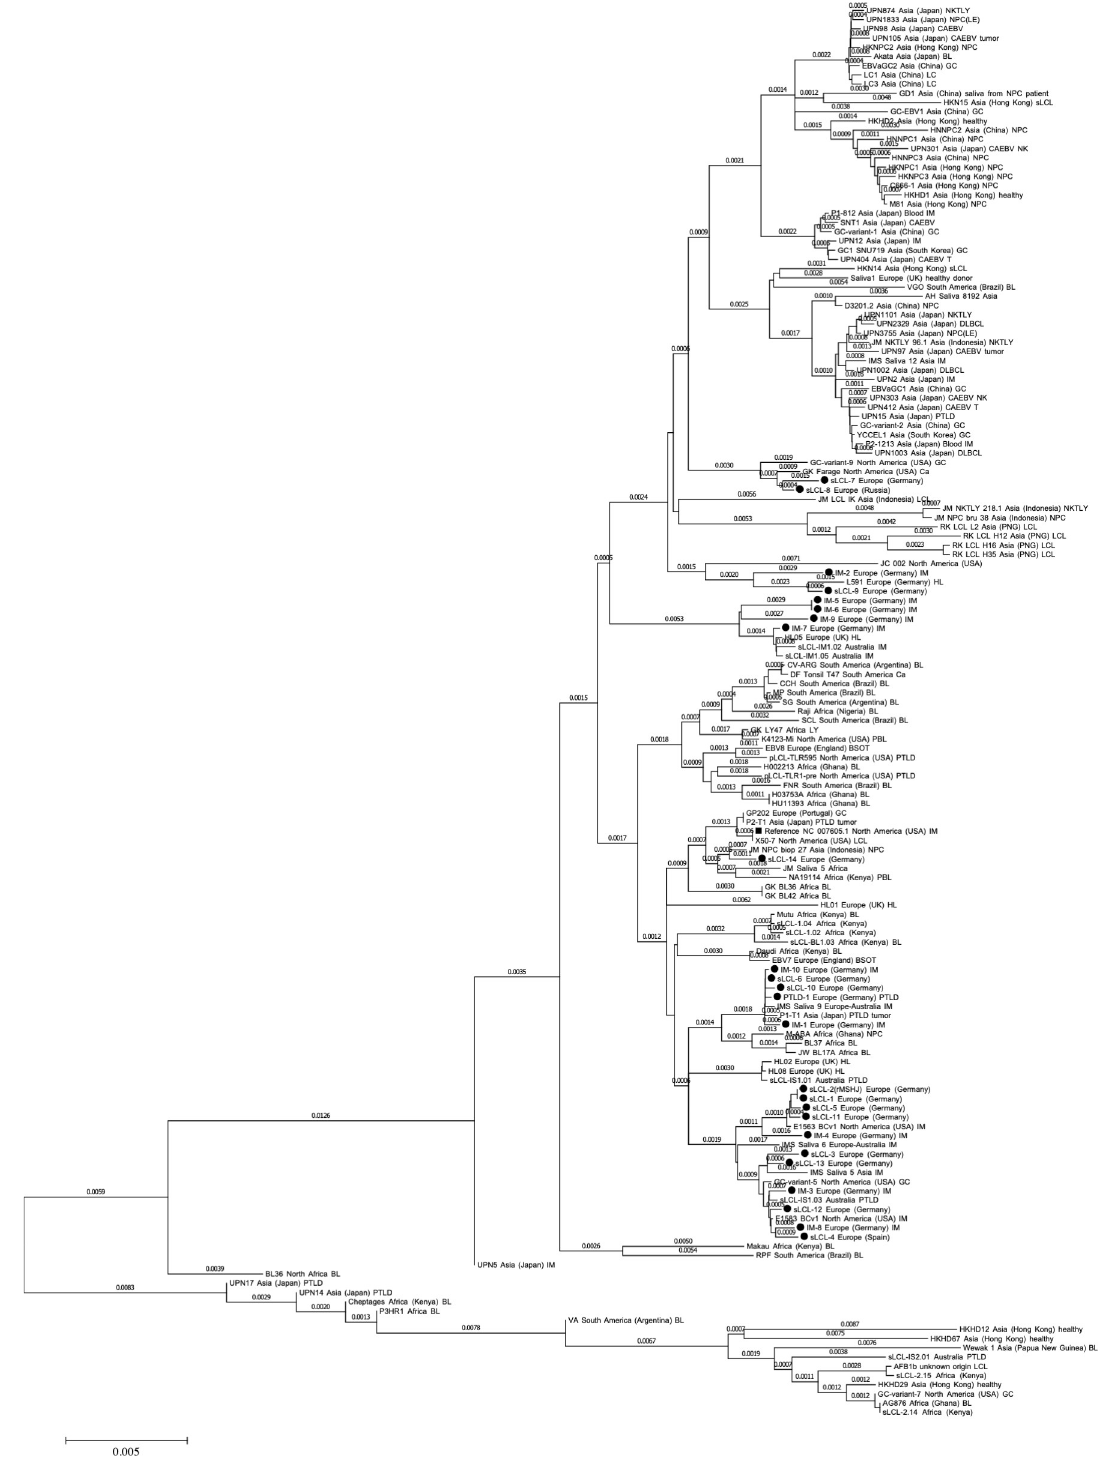
Fig 2. Genetic classification of spontaneous LCLs from patients with IM and iEBVL. The genetic tree shows the genetic distance between our panel of spontaneous LCLs (black dots) and published EBV strains after comparison of the sequences from four of their genes (EBNA2, EBNA3, BZLF1, LMP1).